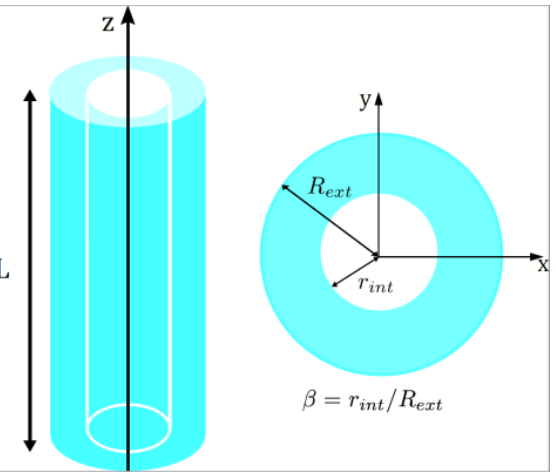
Figure 1. Schematic representation of an isolated magnetic nanotube. Representative geometric parameters are indicated.